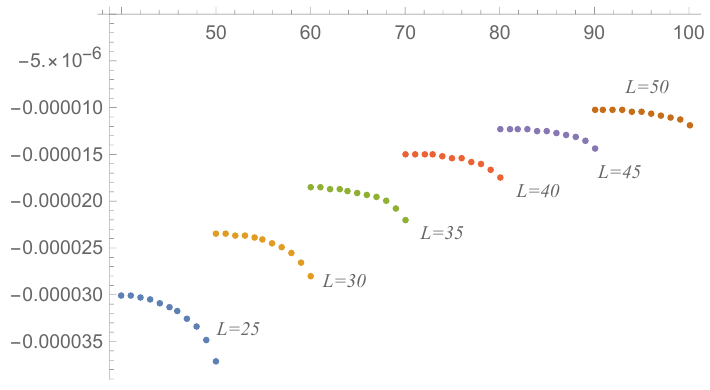
Figure 6 . The final 10 points of the derivative of the EE of the fuzzy sphere ∆ S EE ( x ) for µ = 10 and L = 25 , 30 , · · · , 50 (up to − λ 2 ln λ 2 / 16 R 2 ). The horizontal axis is x . R = 1 .